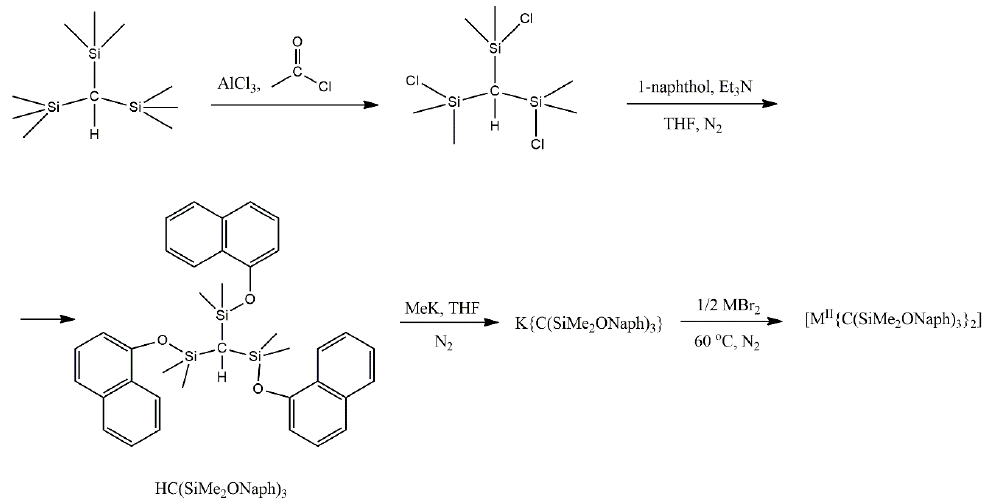
Figure 11. Synthetic scheme for the ligand HC(SiMe 2 ONaph) 3 and preparation of the linear Co(II) and Zn(II) dialkyl compounds 16 and 16a , M = Co, Zn.